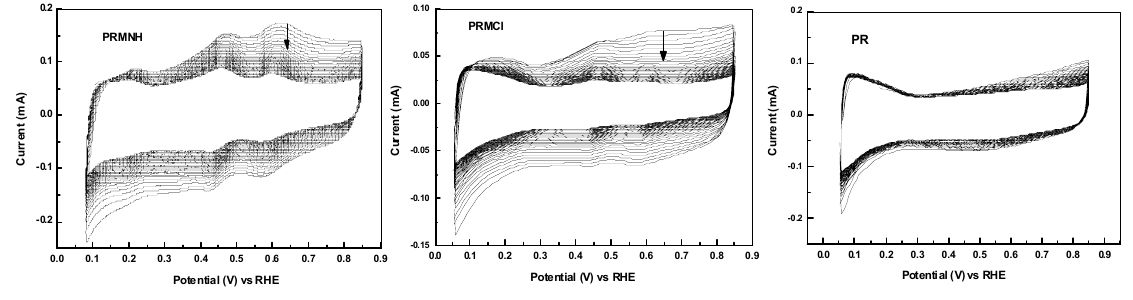
Figure 4. Conventional voltammograms (CV) of electrocatalysts in 0.5 M H v = 0.01 V s − 1 . Adapted from Tsiouvaras et al.